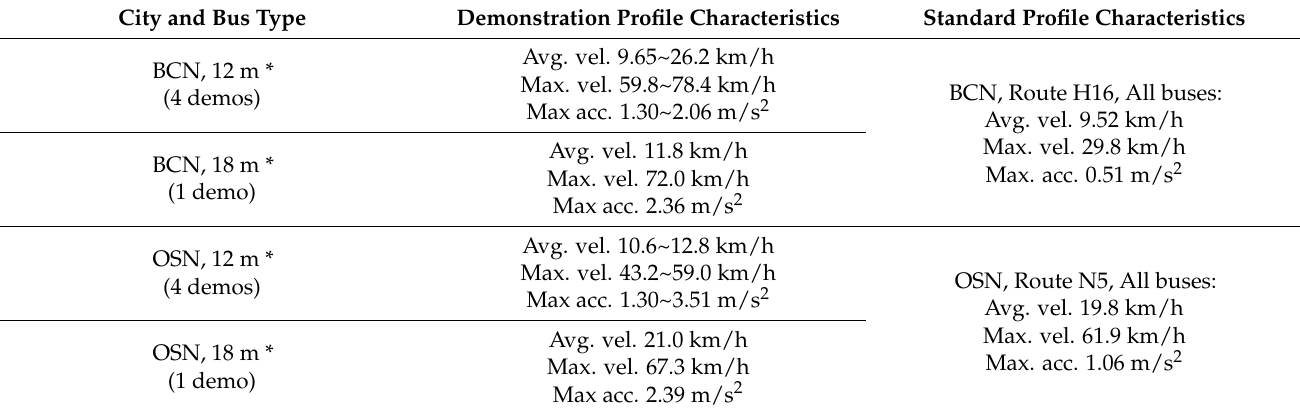
Table 3. Comparison between the demonstration and the standard driving profile